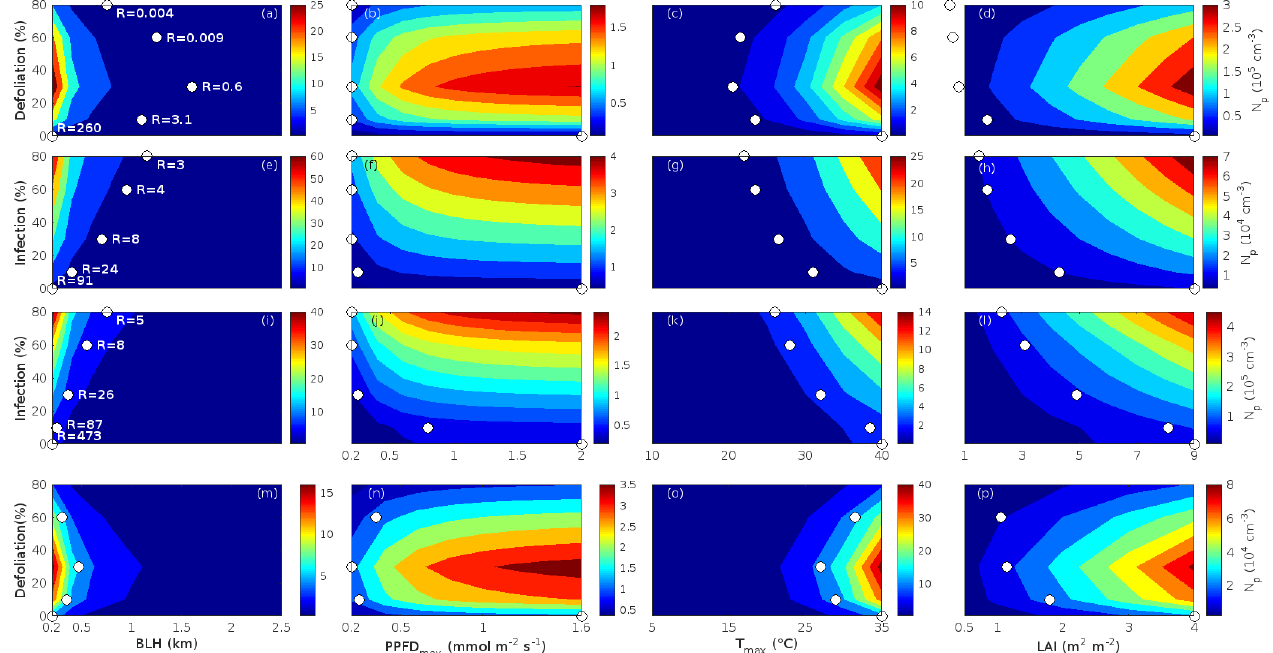
Figure 10. Impact of changed boundary conditions on the number concentrations of newly formed particles in non-infected and biotically stressed forest stands. The number concentration of newly formed particles is expressed as a function of changes in the boundary layer height (a, e, i, m) , light (b, f, j, n) , temperature (c, g, k, o) , and leaf area index (d,h, l, p) for non-infected and infected oak ( a–d , gypsy moth; e–h , powdery mildew), poplar (i–l) , and birch (m–p) stands. Light (b, f, j, n) and temperature (c, g, k, o) are given as the daily maxima, but in the simulations the parameters follow a daily cycle. The displayed LAI (d, h, l, p) is that of a non-infected stand; e.g. at LAI = 7m 2 m − 2 , the simulation for a larval infestation level of 80% has been conducted with LAI = 1.4m 2 m − 2 , which is 20% of the non-infected stand LAI value. Optimal conditions (i.e. leading to highest number concentrations) for non-infected stands are indicated with white markers at an infection level of 0%. White markers located at various infection levels mark the conditions at which an identical or slightly higher number concentration, as produced by a non-infected forest stand at optimal conditions, is reached. No markers are used for 80% defoliated mountain birch (m–p) , since the corresponding number concentrations are always lower than in a non-infested birch stand at optimal conditions. Be aware that white markers in (d) and (p) are not located at the LAI of a non-infected stand but instead at the values used for the simulations. R values (a, e, i) indicate the ratio of isoprene carbon/monoterpene carbon at the locations of the write markers. Be aware that the x axes are different for simulations in Hohenpeißenberg (a–l) and SMEAR I conditions (m–p) except in the case of changing boundary layer height (a, e, i, m)